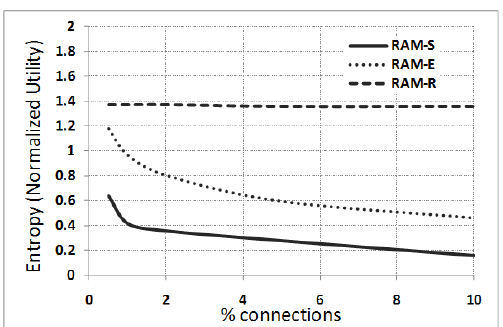
Fig. 8. The resulting entropy of individual utilities for different percentage of overlay connections.